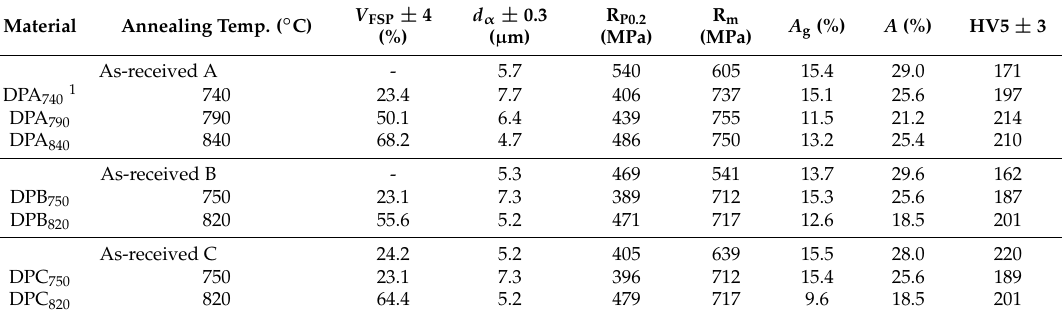
Figure 3. A specimen for the tensile test (unit: mm). Table 3. The mechanical properties of as-received steels and annealed